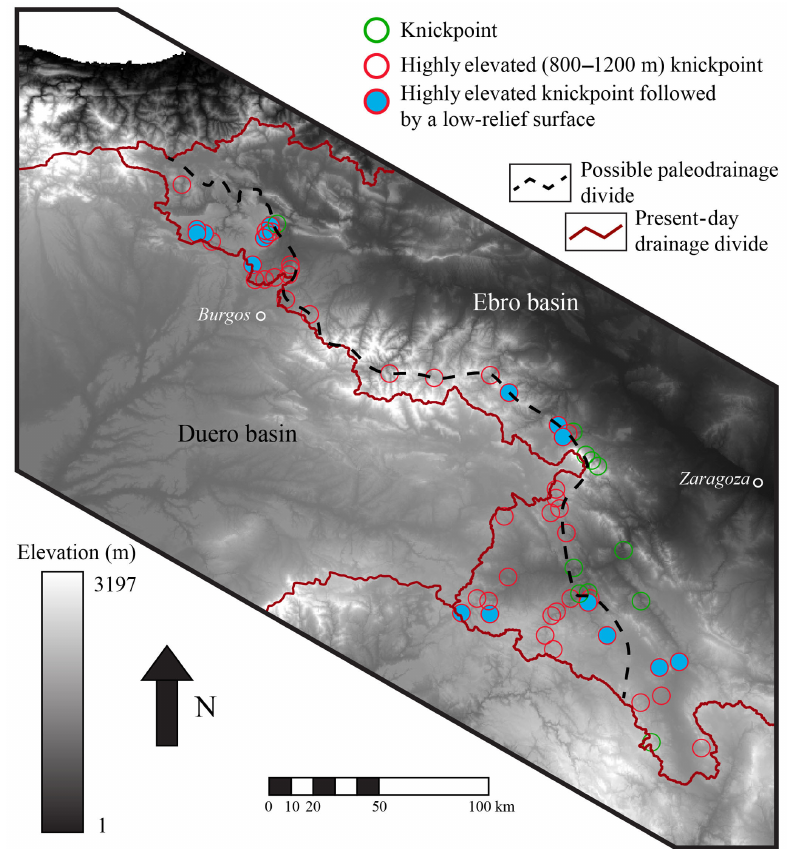
Figure 9. Topographic map showing the location of all the knickpoints and low-relief surfaces that may be associated with river capture. The black dashed line represents a possible paleodrainage divide between the Ebro and Duero basins. The area between this dashed line and the present-day location of the divide in red may have belonged to the Duero basin before being captured by the Ebro basin.